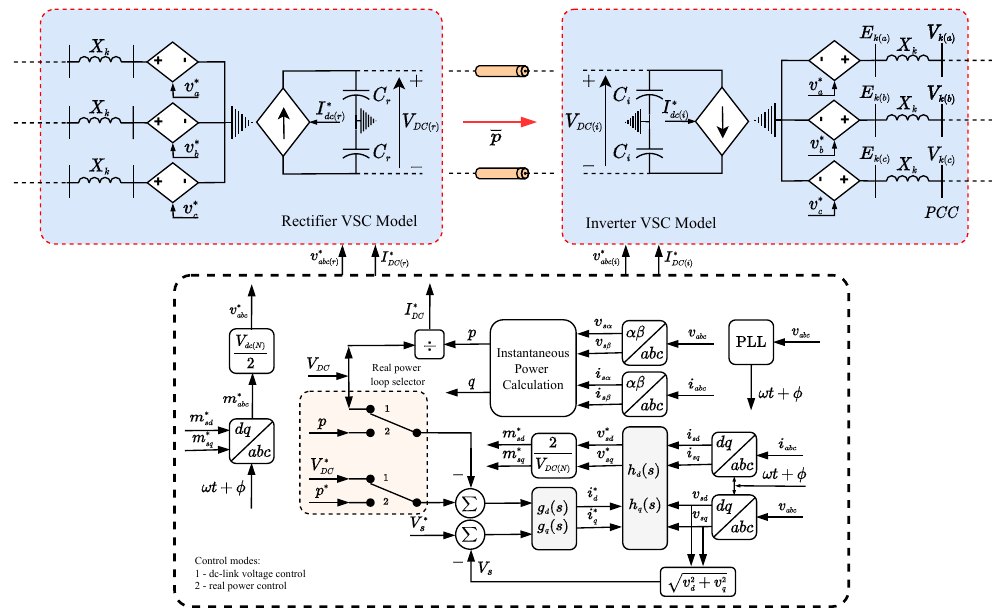
Figure 9. Grid interface of the VSC model and its vector control scheme.